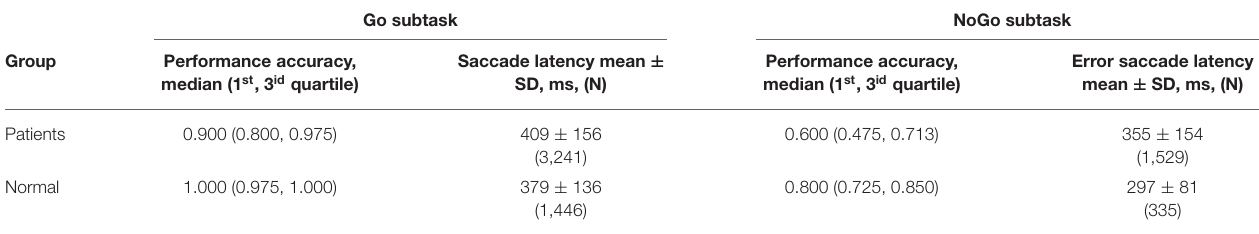
TABLE 3 | Oculomotor parameters from Go/NoGo task experiments.